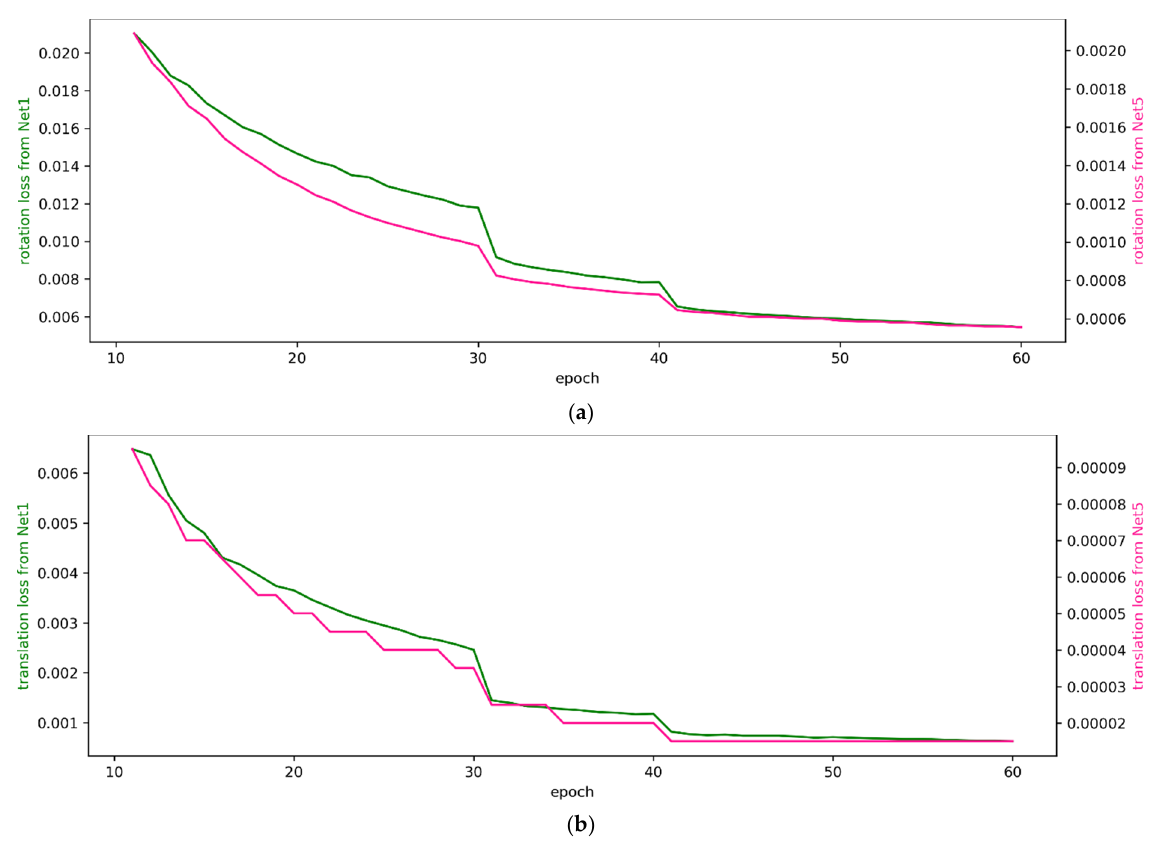
Figure 5. Changes in loss calculated during the training of Net1 and Net5 on the KITTI dataset. ( a ) L rot calculated using Equation (10). ( b ) L trs calculated using Equation